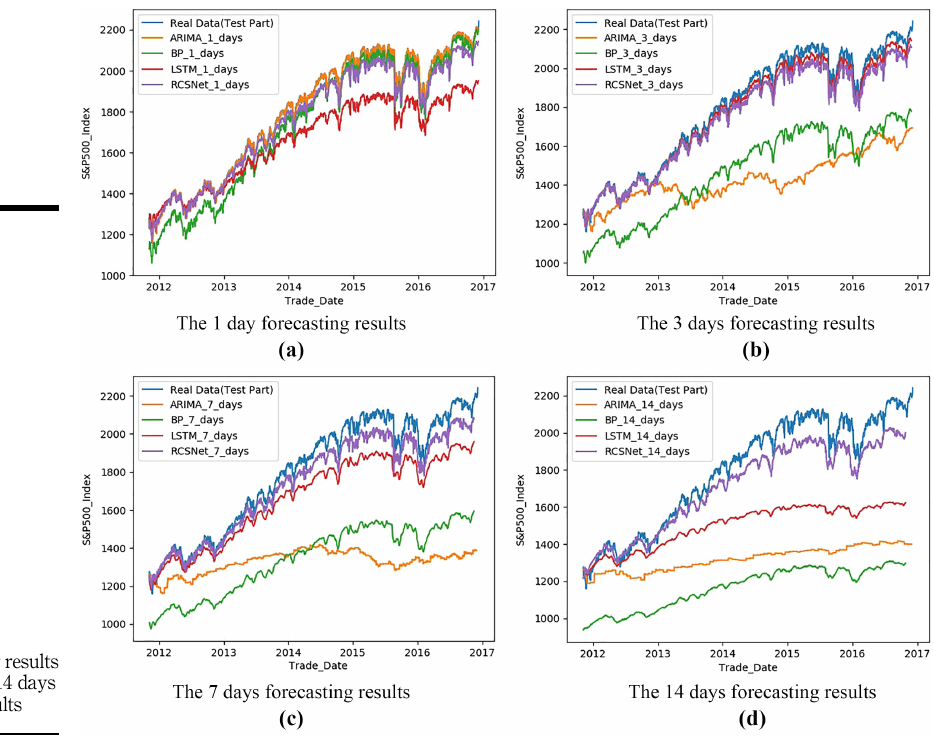
Figure 6. The forecasting results contain 1, 3, 7, 14 days forecasting